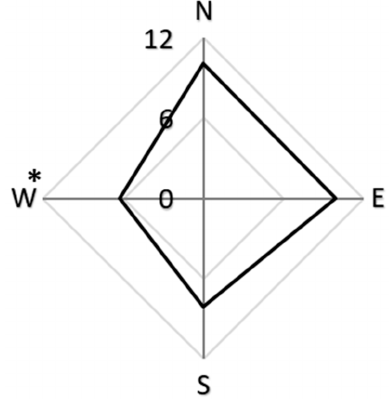
Figure 1. The density of resin beads per square meter on red pines, Pinus resinosa , by cardinal direction. The asterisk (*) indicates significantly lower resin bead density ( p = 0.04).